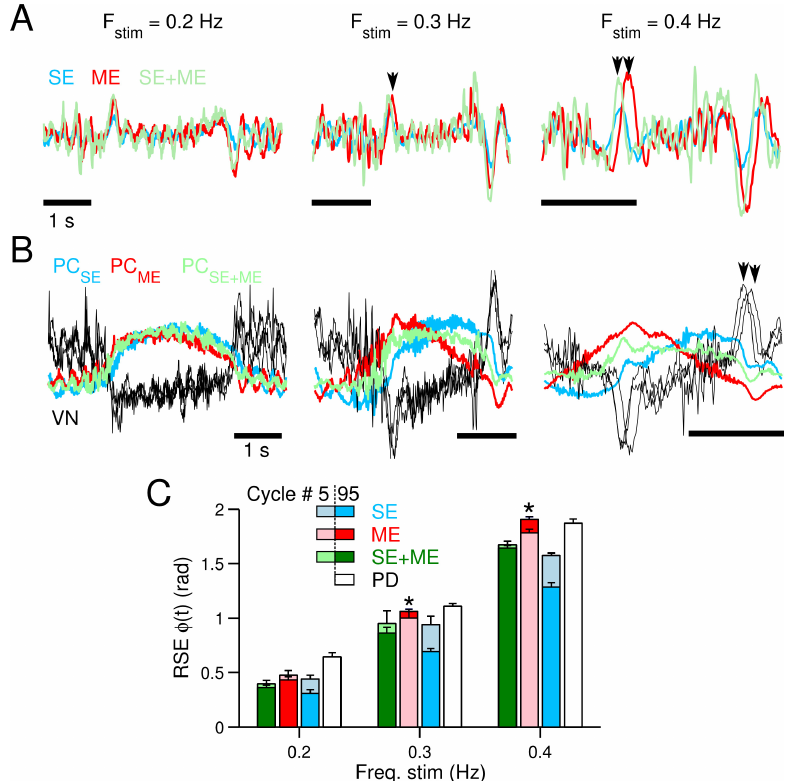
Figure 4. Firing rates of climbing fiber (CF) and the Purkinje cell (PC) during the control of the two-wheeled balancing robot. Three frequencies of φ des ( t ) are shown, 0.2, 0.3 and 0.4 Hz. ( A ) CF activity when carrying sensory error (SE) (blue), motor error (ME) (red) and SE + ME (green). Arrows show that CF carrying ME is delayed with respect to the other types of CF. ( B ) Firing rate of the Purkinje cell and vestibular nucleus (VN, black) at the different frequencies tested. Arrows show that the vestibular nucleus activity produced with CF carrying SE and ME is clearly different at 0.4 Hz. ( C ) Averaged control performance in terms of the root mean squared error (RSE) of φ ( t ) at Cycles #5 (light colors) and #95 (dark colors) at the different frequencies of the desired